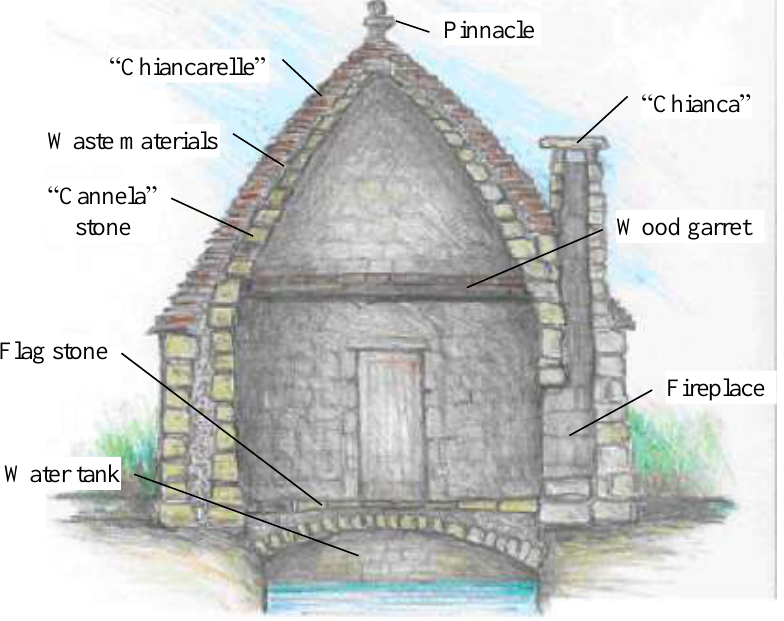
Figure 8. Structure of a trullo.